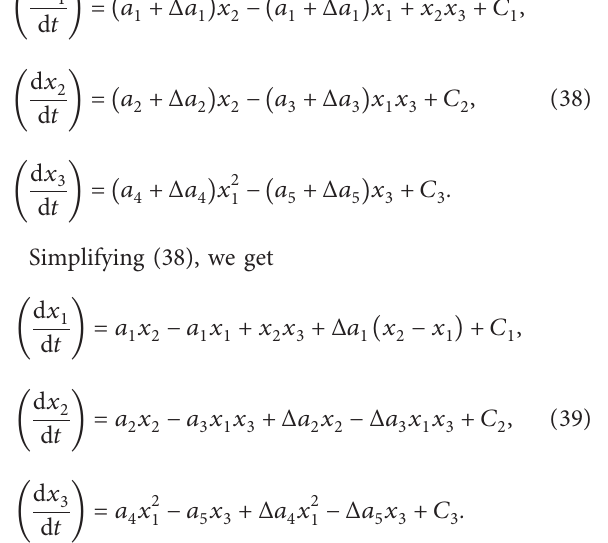
Figure 8: Phase portrait of the state variable x Table 2: The input/output gains of the